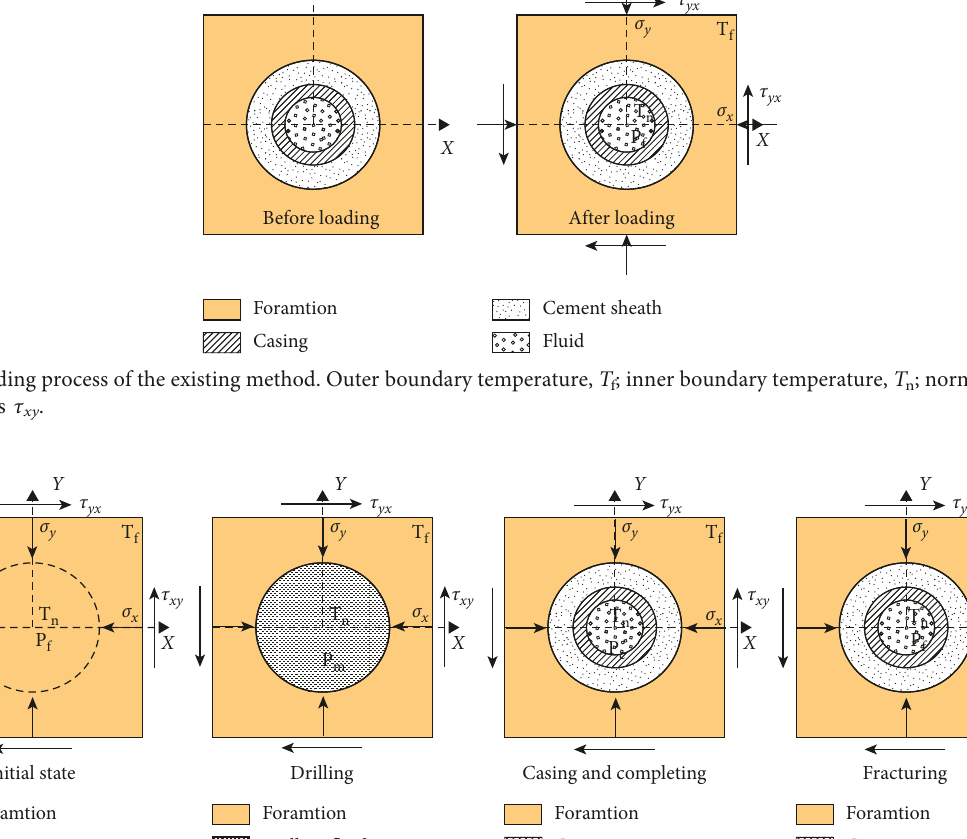
f ; inner boundary temperature, T n ; normal stress, σ x and σ y ;